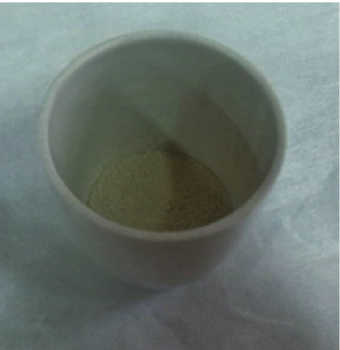
Fig. 1: Precursor before self-combustion